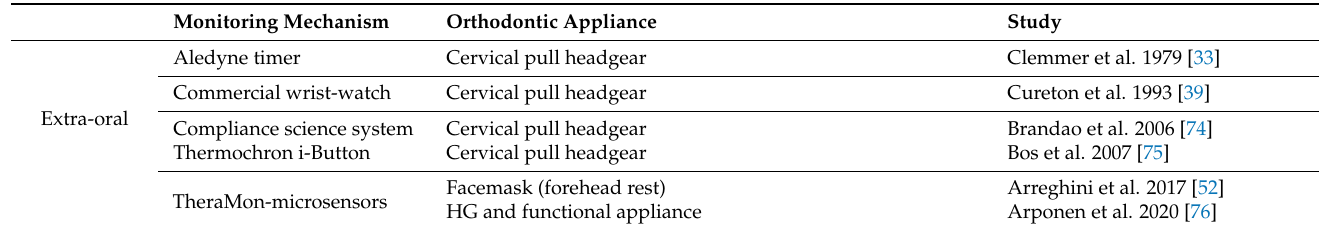
Table 1. Wearable technologies for monitoring compliance with orthodontic